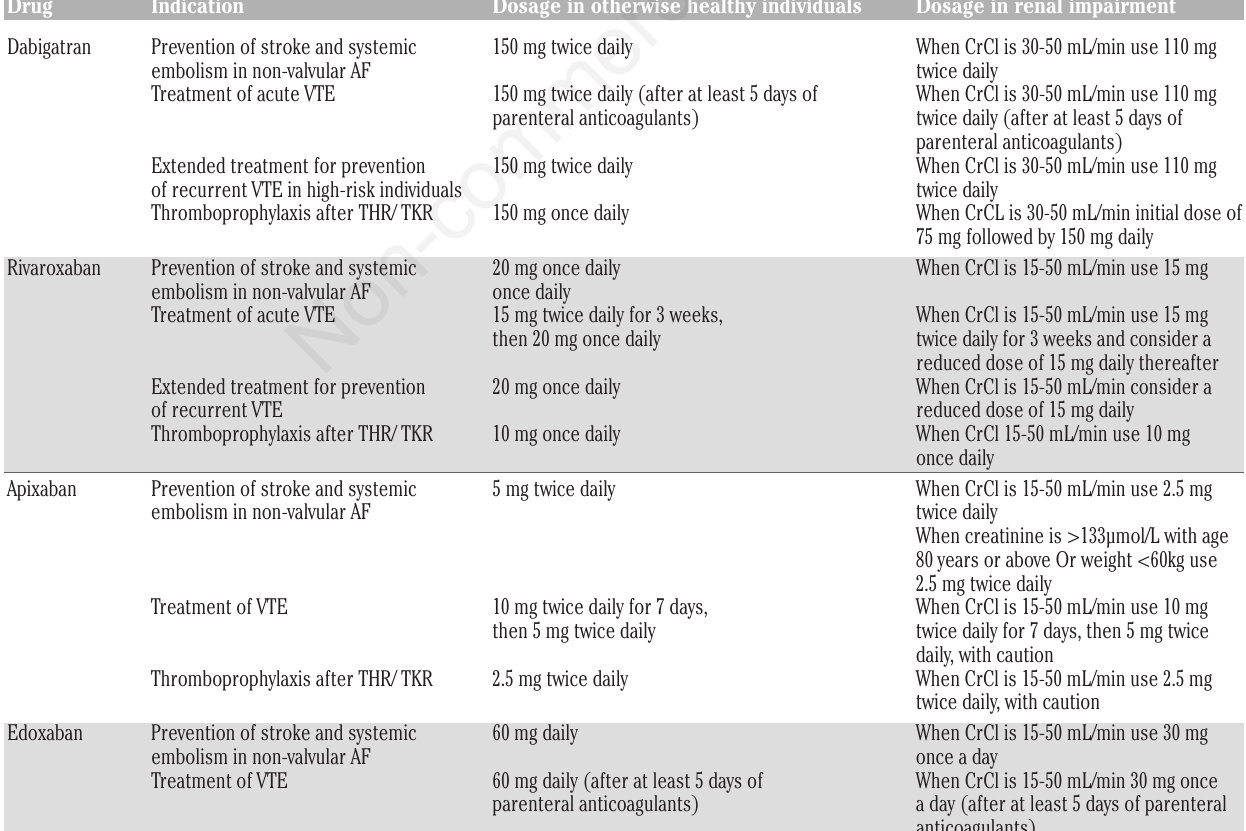
Table 1. Summary of indications and dosing for direct oral anticoagulants in otherwise healthy individuals and those with renal impair- ment (dabigatran is contraindicated when the creatinine clearance (CrCl) is <30 mL/min, rivaroxaban, apixaban and edoxaban are con- traindicated when the CrCl is <15